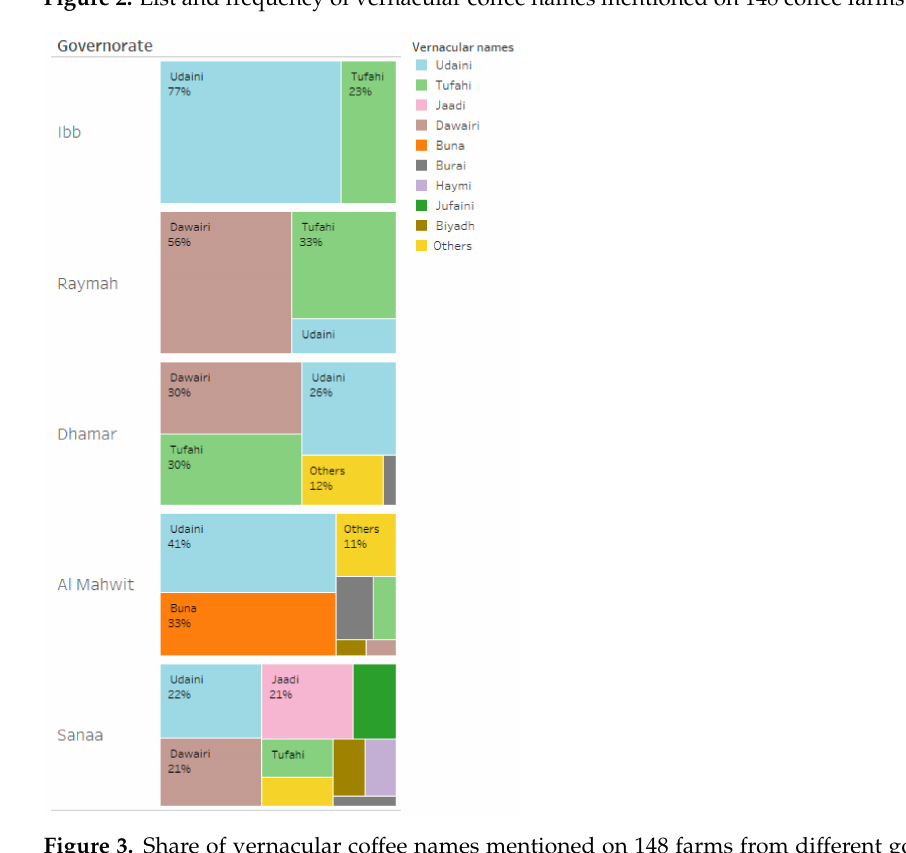
Figure 2. List and frequency of vernacular coffee names mentioned on 148 coffee farms in Yemen.